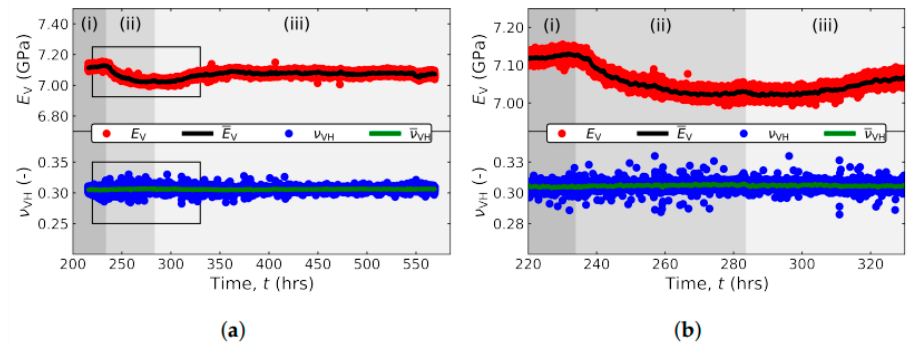
Figure 5. ( a ) Young’s modulus (red dots, average: black line) and Poisson’s ratio (blue dots, average: green line) as a function of time. The three phases are (i) consolidation; (ii) flow of brine; (iii) flow of scCO 2 -saturated brine (see text in Section 2.2 above); ( b ) Zoom on the rectangular sections marked in ( a ).